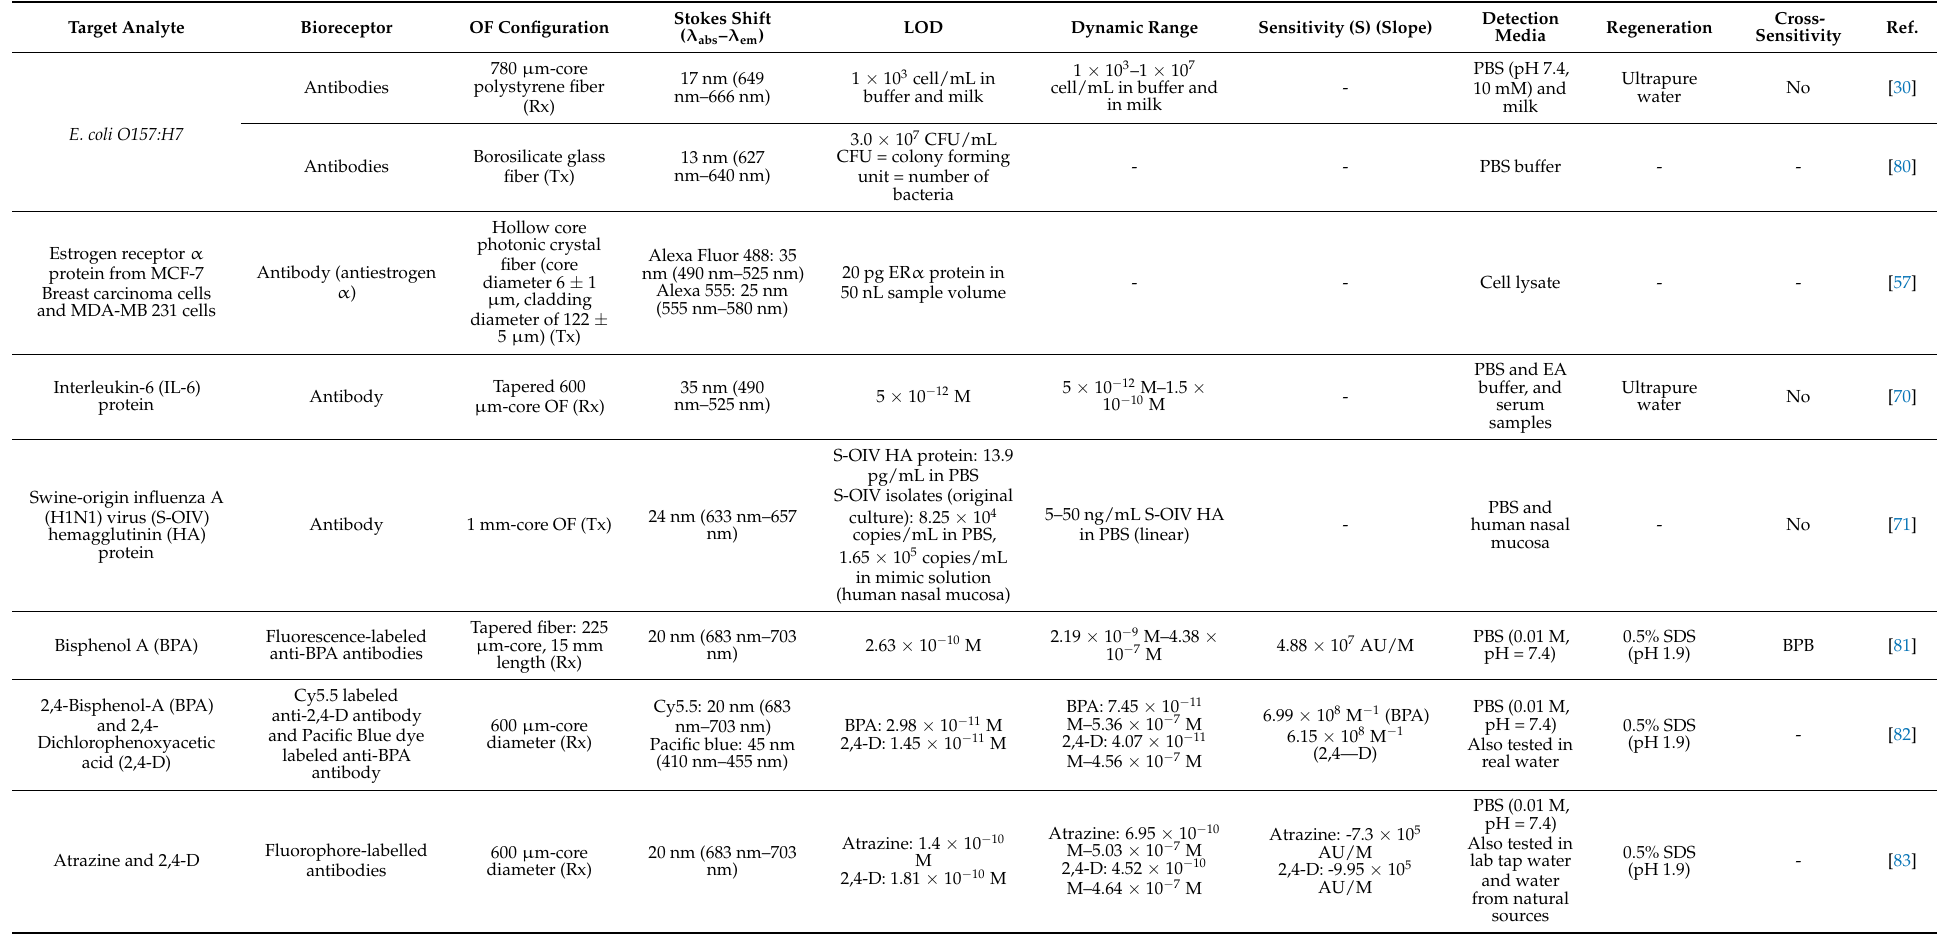
Table 3. Optical fiber biosensors based on luminescence using antibodies as bioreceptors. The dash indicates that information about that parameter is not available in the original